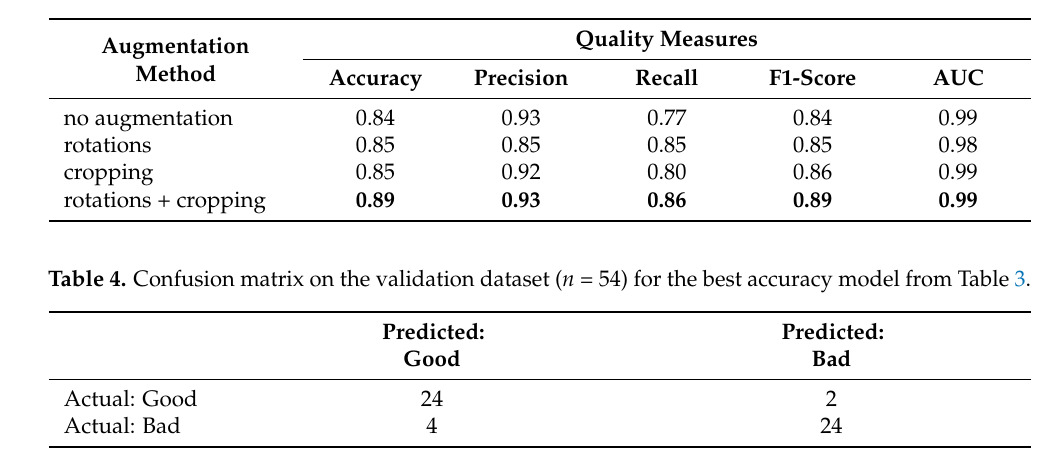
Table 3. Classification quality measures on the validation set for the VGG13 model with various augmen- tation methods applied to the input images preprocessed with histogram equalization. Best values are highlighted in bold. Quality measures and image augmentation methods are described in Methods.